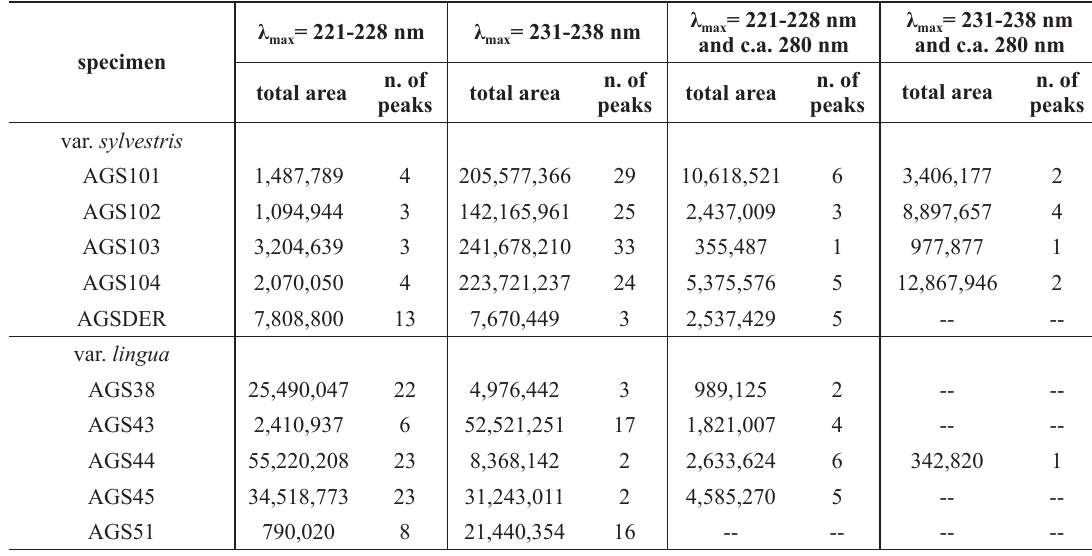
HPLC-DAD analyses data of leaf extracts from different specimens of C. sylvestris . The number of peaks and total area of selected peaks based on UV spectra/λ are presented. max